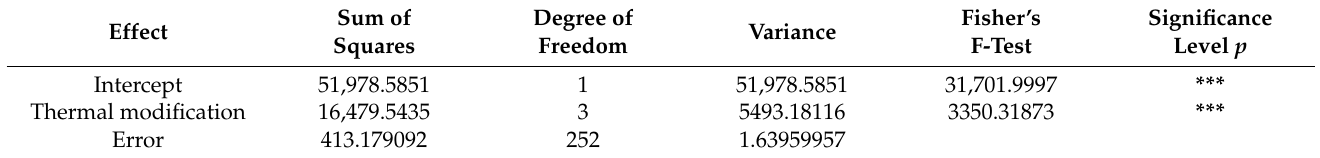
Table 5. Statistical evaluation of the factors affecting the change in the b * value.